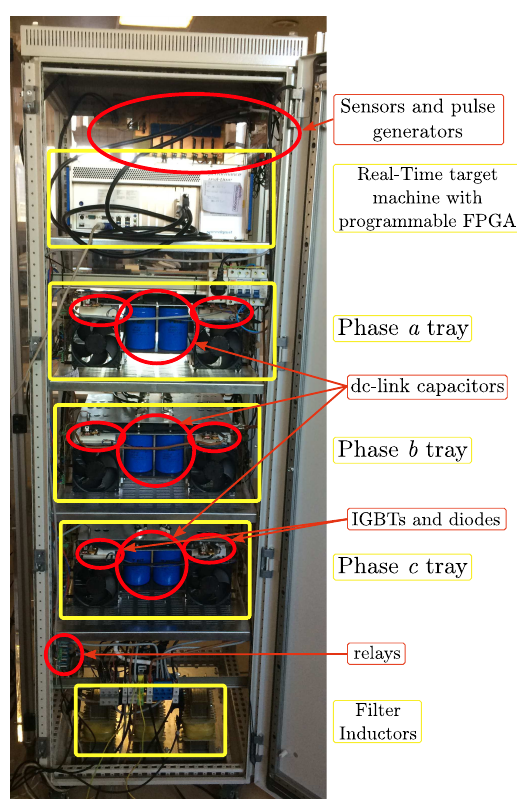
Figure 5. Experimental prototype of the three-level NPC rectifier. Table 1. Circuit and control